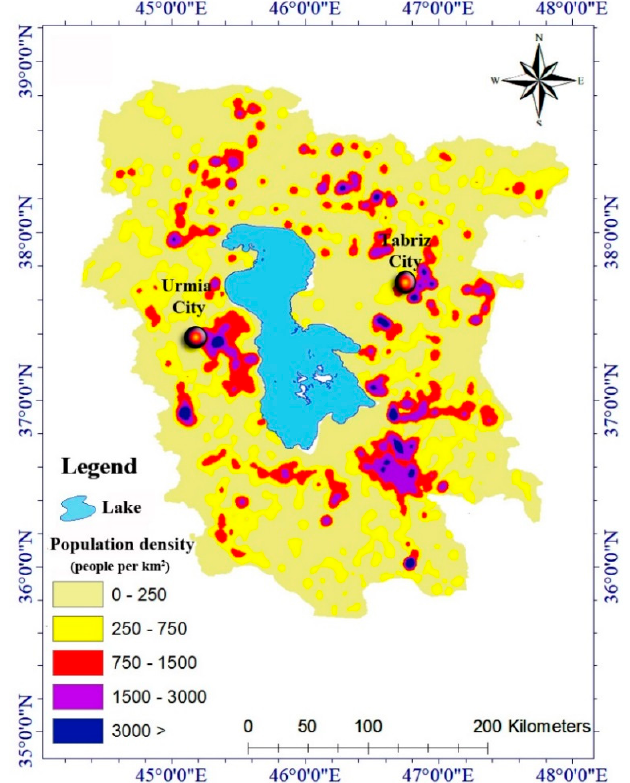
Int. J. Environ. Res. Public Health 2020 , 16 , x FOR PEER REVIEW Figure 10. Population density (people per km 2 ) around Lake Urmia. Figure 10. Population density (people per km 2 ) around Lake Urmia.